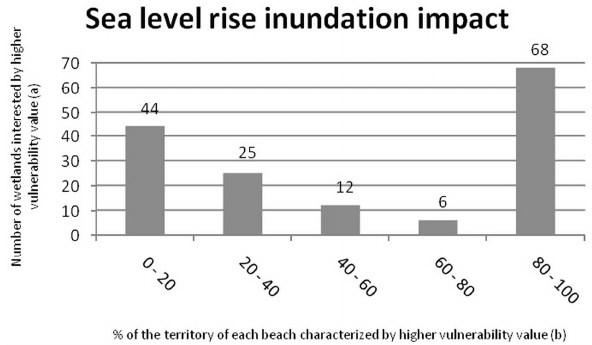
Fig. 5. Vulnerability of wetlands to the sea level rise inundation impact: number of wetlands affected by higher vulnerability values in the case study area (a) , according to the percentage of the territory of each wetland characterized by higher vulnerability values (b)